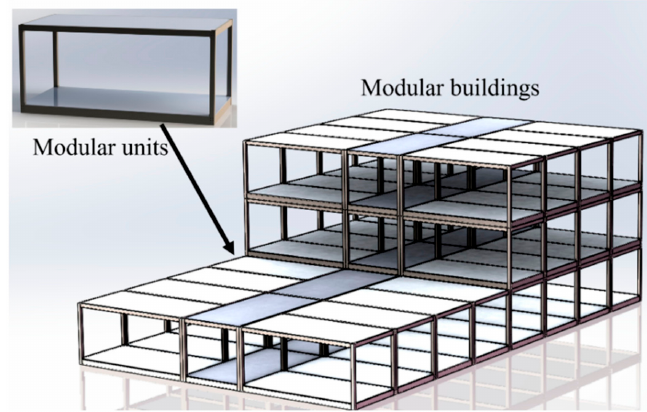
Figure 1. Assembling process of modular